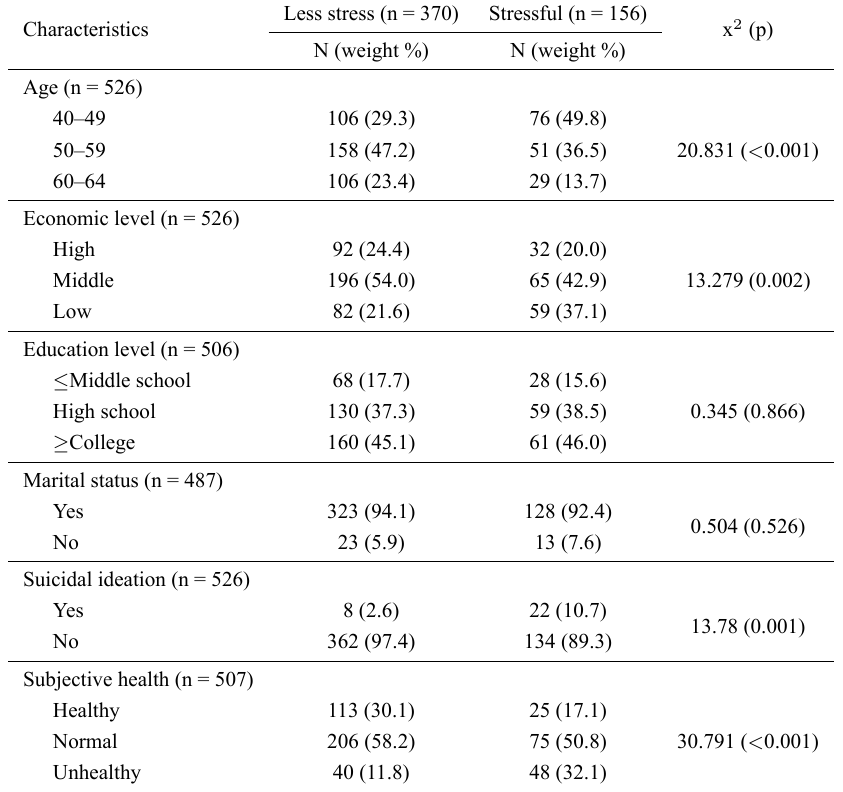
Table 1. Comparison of general characteristics according to stress level (n = 526).